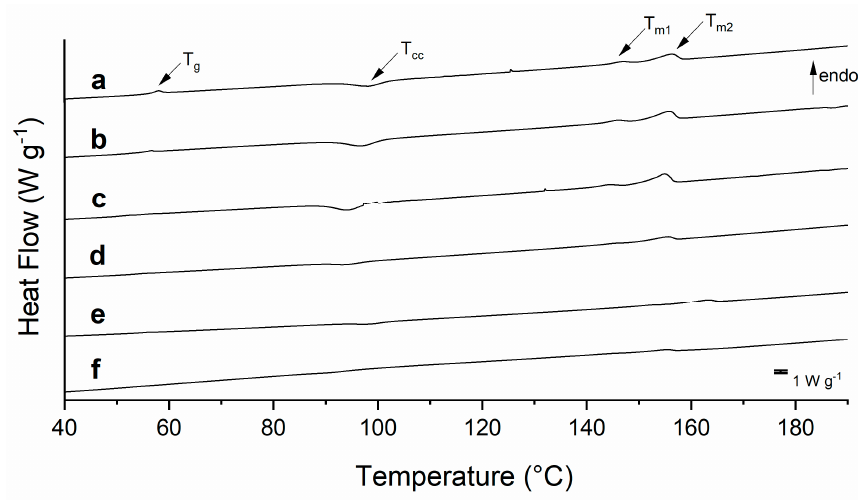
Figure 1. DSC curves for (a) PLA; (b) P95c5; (c) P85C15; (d) PLAGE; (e) P95C5GE; and (f) P85C15GE.